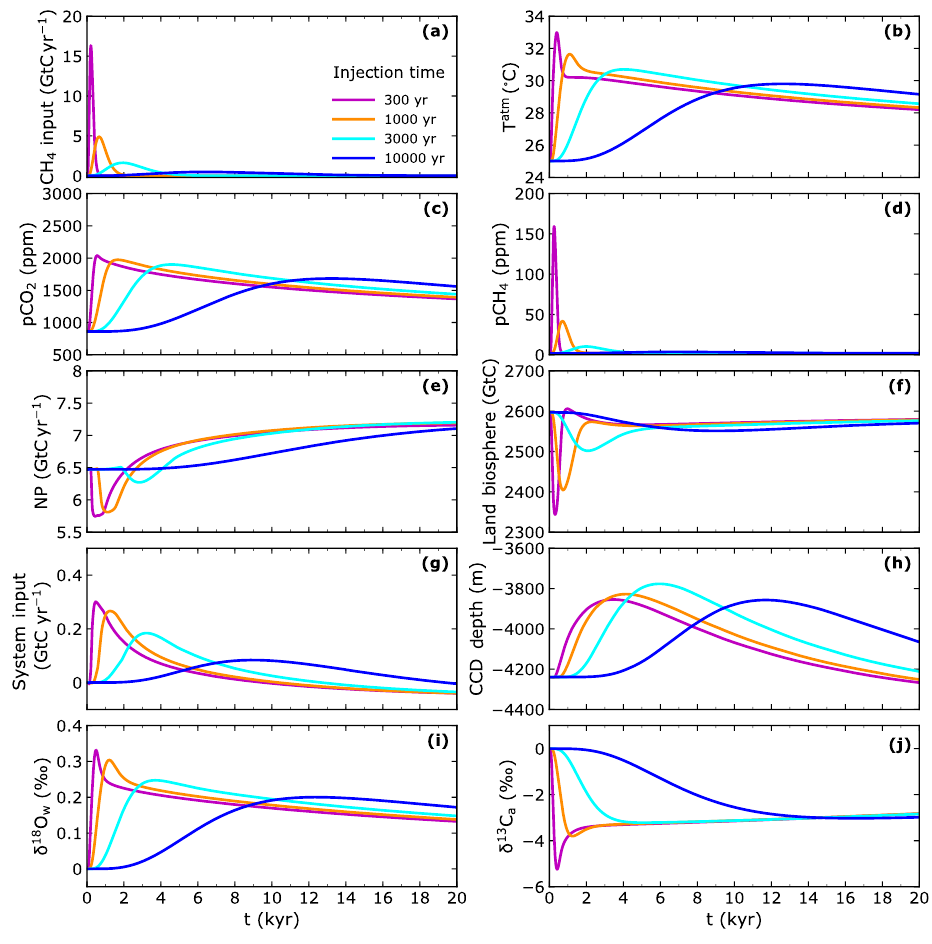
Figure 8. Results for 20000-year simulations for different methane input timescales for an input of 4000GtC with half the input dissolved in the ocean and half escaping as gas to the atmosphere. Properties plotted in (a–j) as in Fig.